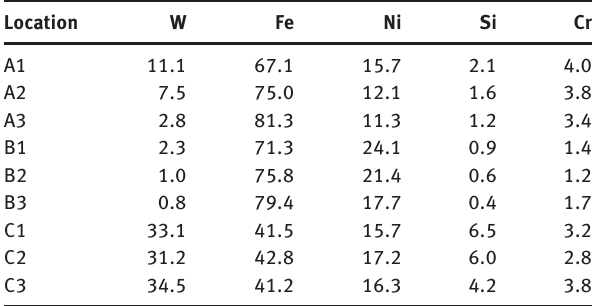
Table 4: EDS results of locations shown in Figure 6.